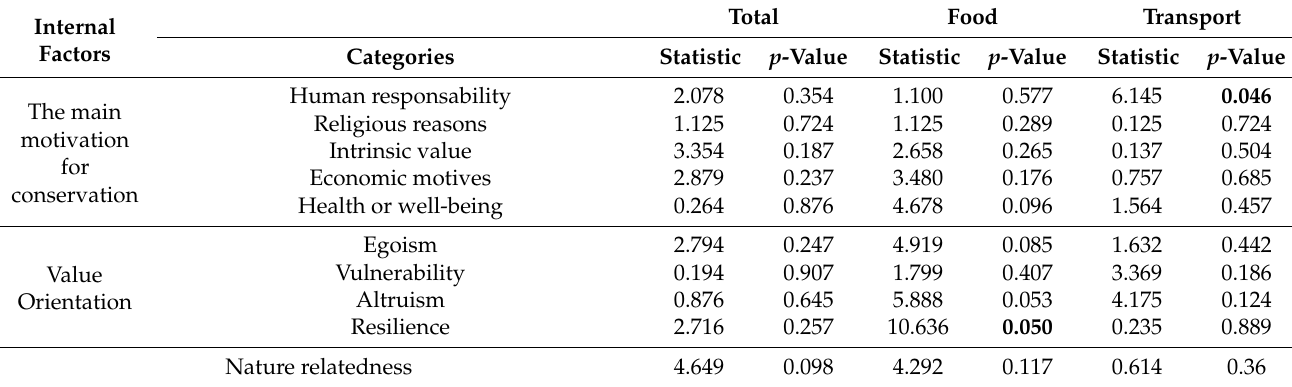
Table 5. Differences in CF across religious groups for each internal